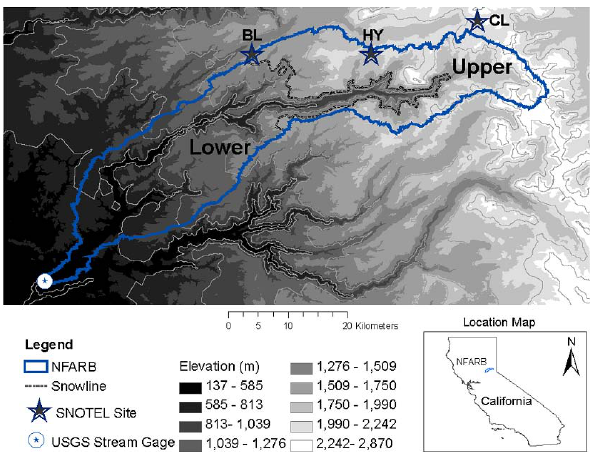
Fig. 2. Climatic characteristics of the NFARB sub-basins during the entire study period (WY1979–2002), training period (WY1979– 1984), and prediction period (WY1991–1996). Mean annual tem- perature at various percentiles over the lower (a) and upper (b) sub- basins are highlighted, as well as the annual areal precipitation at various percentiles over the lower (c) and upper (d)